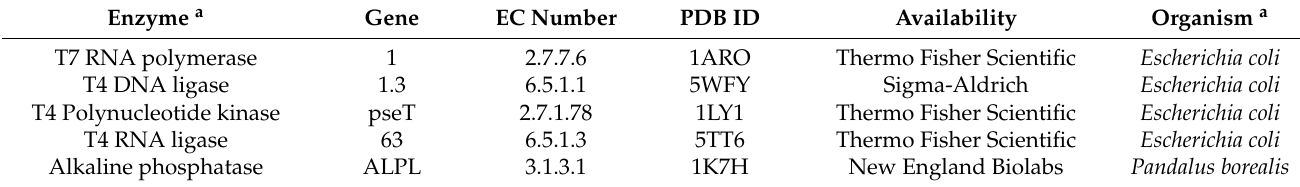
Table 3. Enzymes involved in IVT and DNA and RNA ligation.